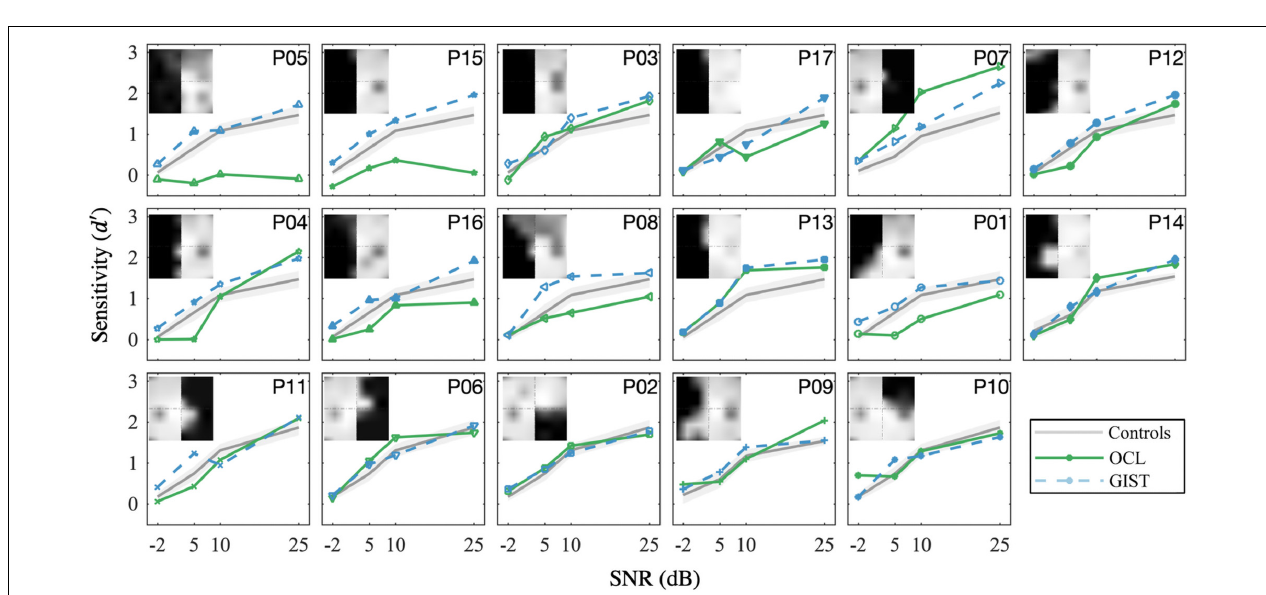
FIGURE 3 | Effect of local occlusions on participants’ performance in scene discrimination tasks. (A) Average empirical (markers) and simulated sensitivity (lines) as a function of signal-to-noise ratio (SNR) and the extent of the simulated VFDs (qVFDs or hVFD) for healthy observers. (B) GIST classification accuracy relative to healthy controls’ performance. The sensitivity difference of the classifier to human behavior is plotted as a function of the simulated VFD and SNR. (C) Average sensitivity for participants with quadrantanopia VFD (P02, P06, P09, P10, P11, and P14) and (right panel) participants with hemianopia VFD; each group was compared with corresponding simulated VFDs in healthy controls. Additionally, the sensitivity per SNR condition of the individual participant with occipital lesion is plotted, illustrating the large variability in the OCL group (see also Figure 4 ). Error bars and shaded areas show the CI 95% . * p < 0.05 after false discovery rate (FDR) correction.